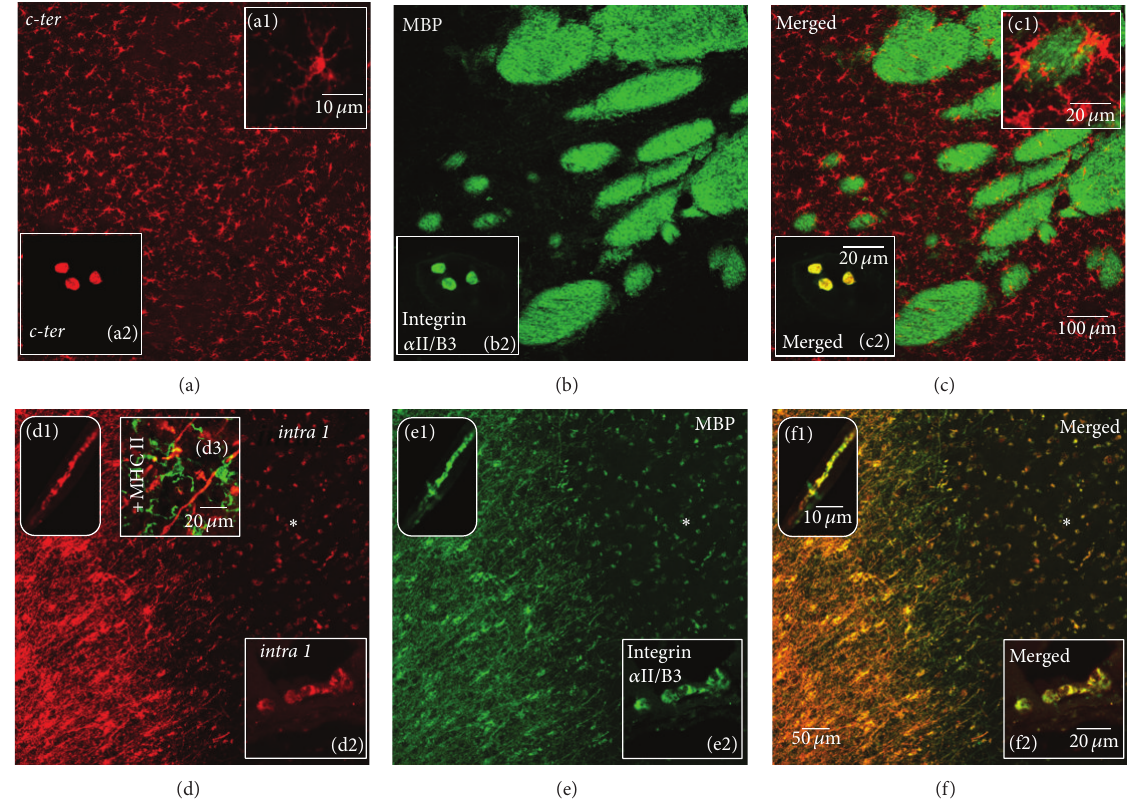
Figure 5: P2Y 12 receptor in human cortex. Sections from human healthy and SPMS frontal cortex were analyzed by double immunofluores- cence and confocal microscopy for the immunoreactive markers c-ter (red, panels (a), (c); insets a1, a2, c1; yellow merged, inset c2), intra1 (red, panels (d), insets d1, d2, d3; yellow merged, panel f, insets f1, f2), MBP (green, panels (b), (c), (e), insets c1, e1; yellow merged, panel (f), inset f1), MHC II (green, inset d3), and integrin 𝛼 II/ 𝛽 3 (green, insets b2, e2; yellow merged, insets c2, f2). The asterisks show decreased P2Y 12 immunoreactivity in proximity to MS